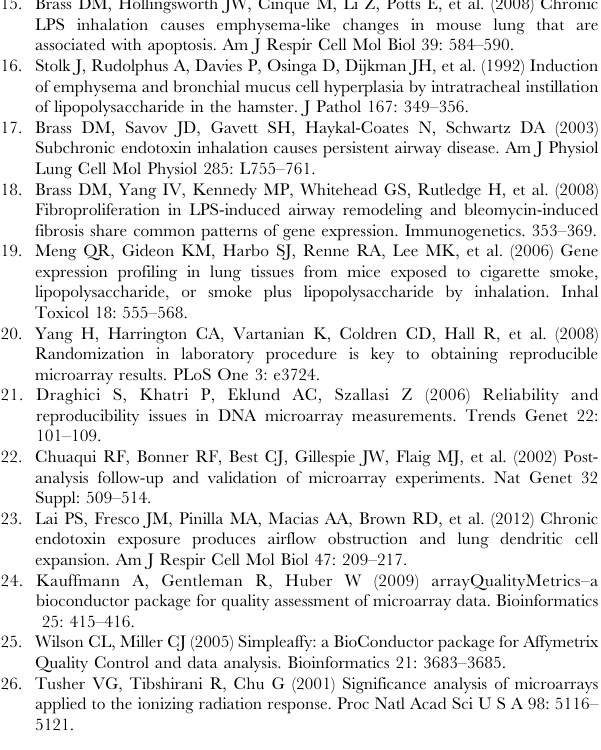
Figure S3 Heatmap based on log 2 fold change of 101 genes in gene signature in smoke, endotoxin, and smoke plus endotoxin exposed mice as compared to air exposed (control) mice. Gene signature accurately classifies between these groups. Table S1 Annotation of 101 gene signature with gene name and MGI identifier. Table S2 Pubmed search of genes present in gene signature previously reported to be associated with asthma. Table S3 Pubmed search of genes present in gene signature previously reported to be associated with